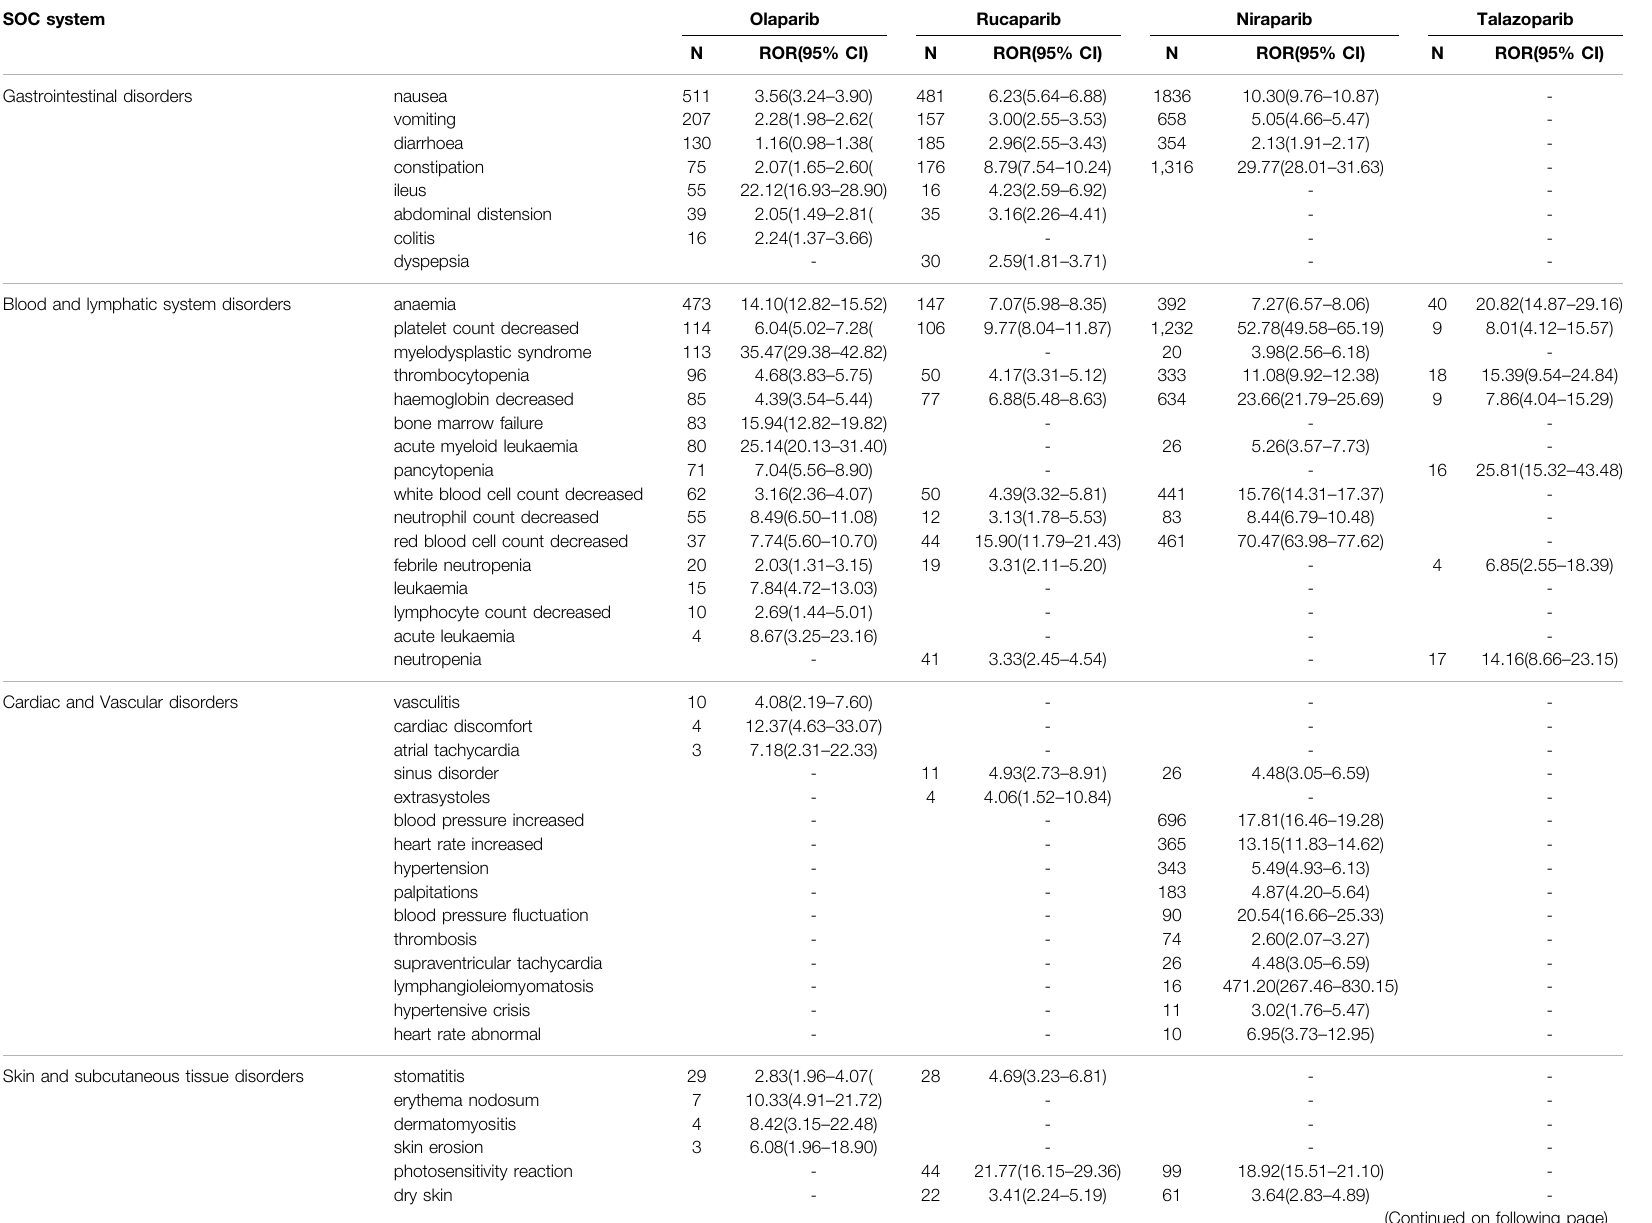
TABLE 4 | Signal strength for PARPi agents based on PT level in